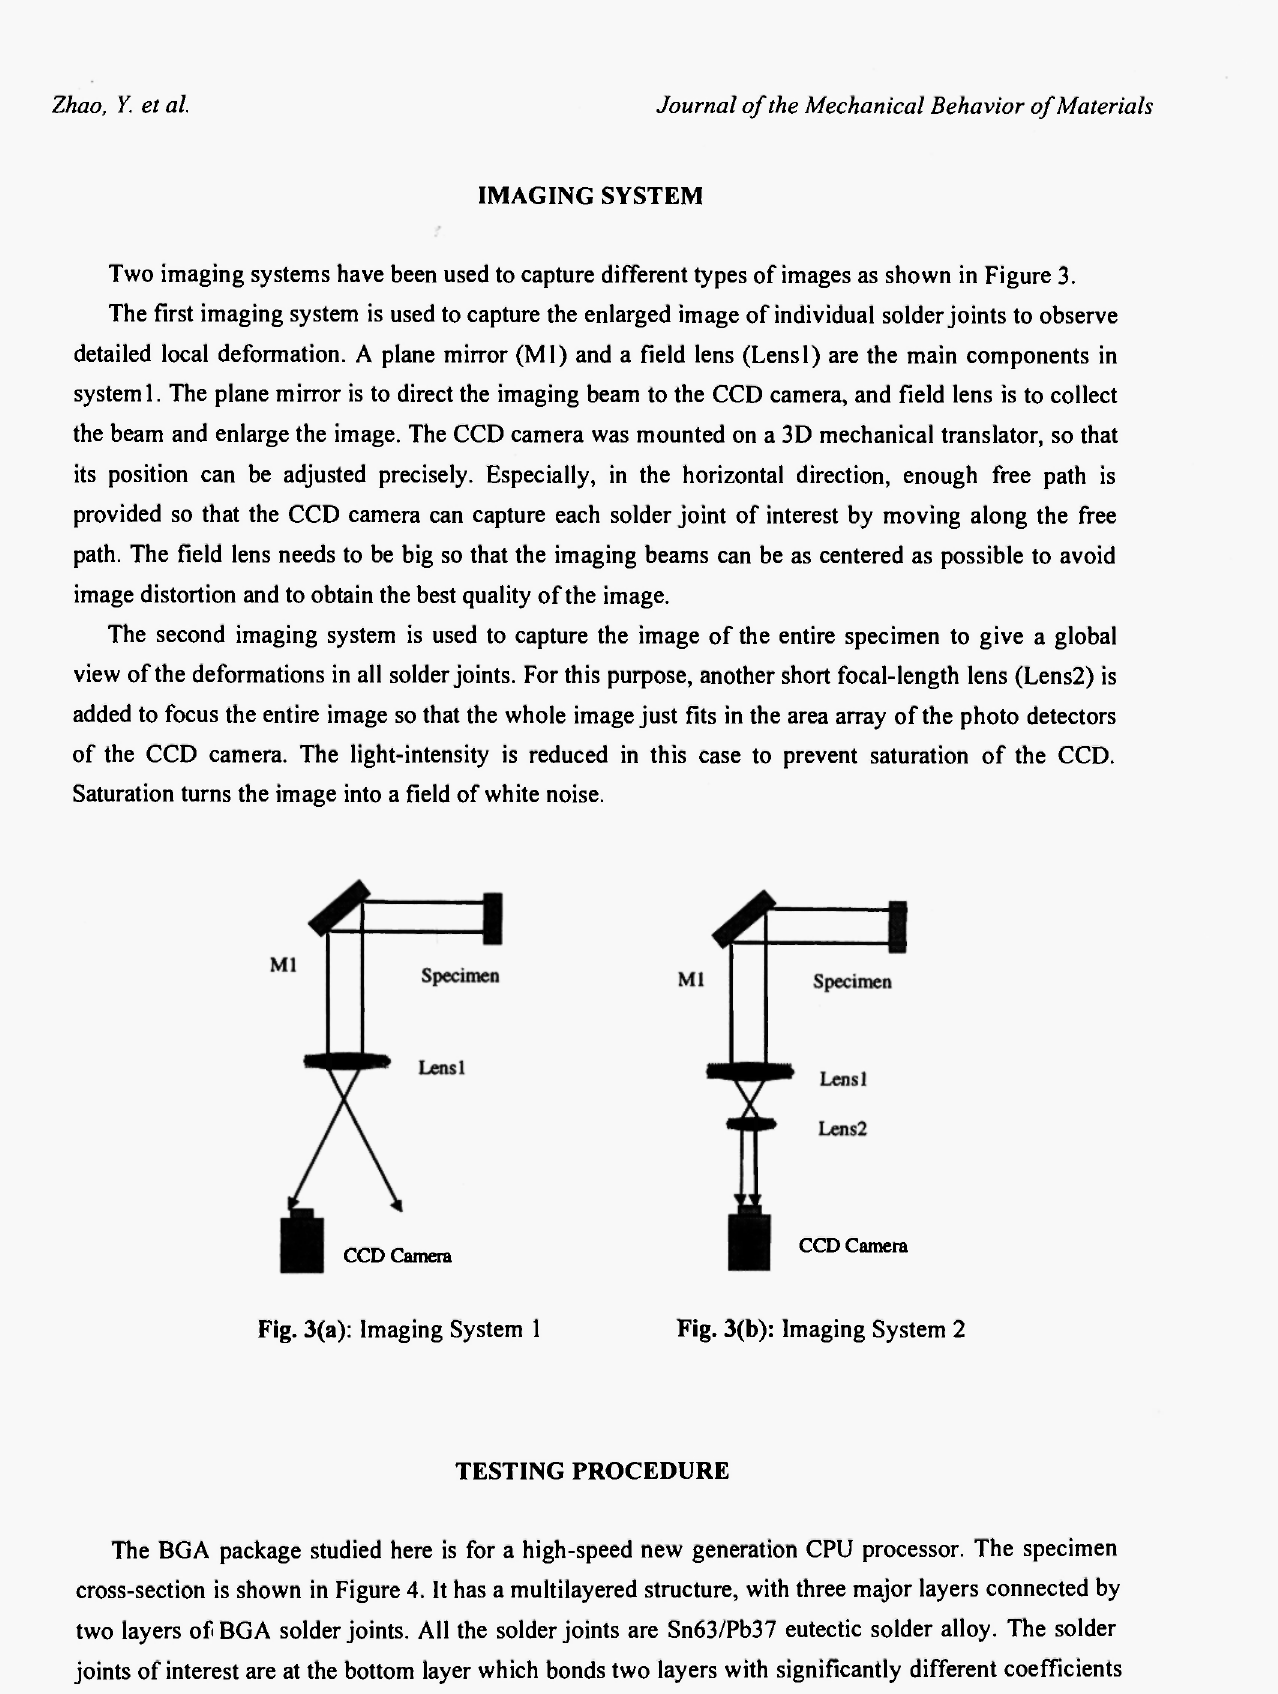
Fig. 3(a): Imaging System 1 Fig. 3(b): Imaging System